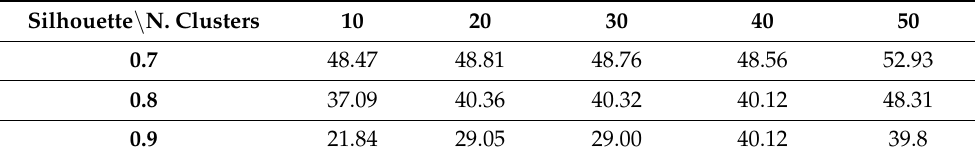
Table 21. Clustering performance in terms of silhouettes using the reduced dataset with SPQR. Silhouette \ N. Clusters